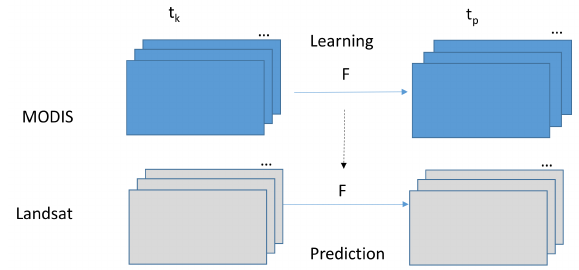
Figure 2. Proposed prediction